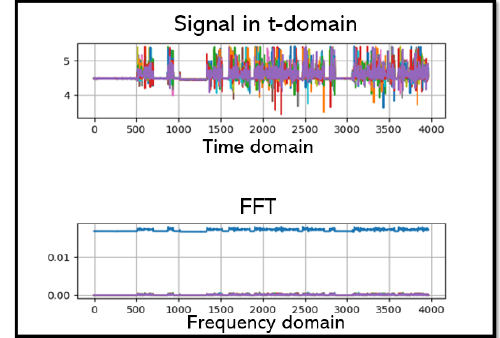
Figure 11. Conversion result of data set from time domain to frequency domain.